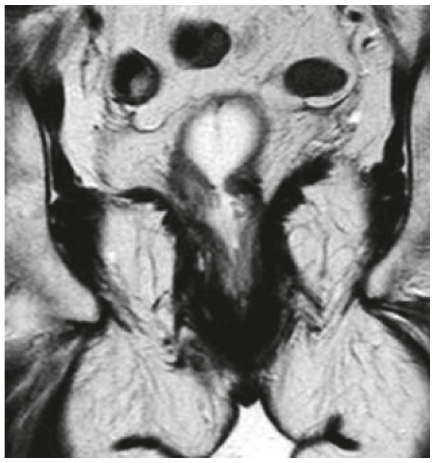
Figure 4: Small, uncompliant neorectum associated with signi fi cant narrowing of the anastomotic ring in a fi fty-four-year men with fecal urgency and staining episodes. Compare it with that shown in Figure 1(b).